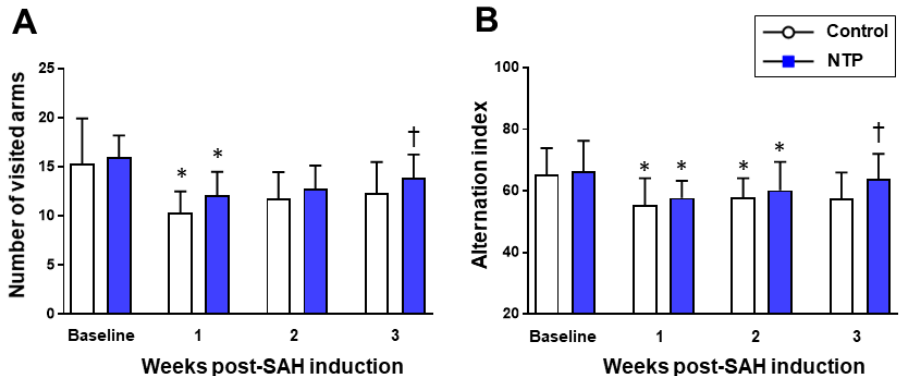
Figure 5. Time–course changes in the chronic phase after SAH induction in the control and neurotropin groups. Number of visited arms ( A ). Alternation index ( B ). * p < 0.05 vs. baseline; † p < 0.05 vs. control; two-way ANOVA with a post hoc analysis (Bonferroni–Dunn’s test). NTP, neurotropin.